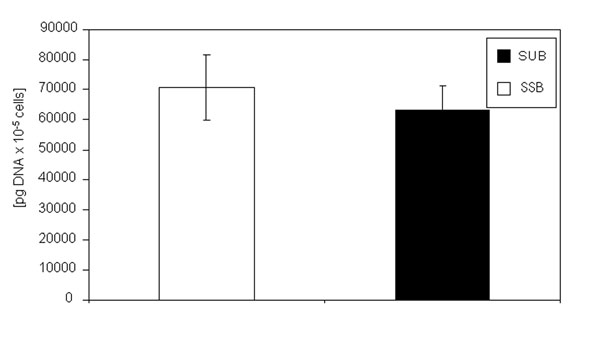
DNA concentration